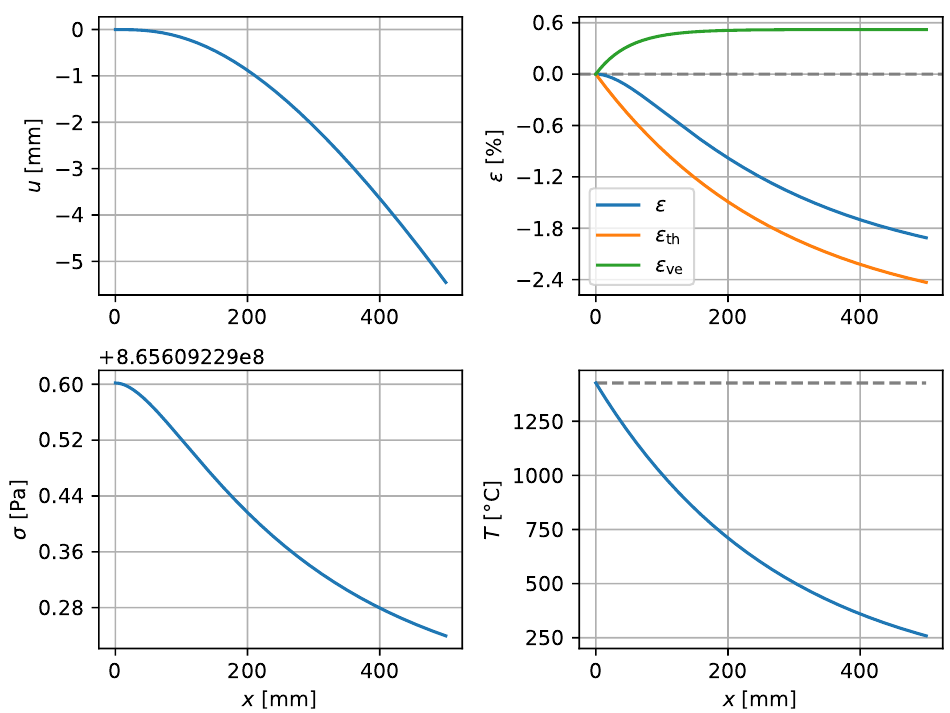
Figure 7. Artificial high-viscosity example, t ret = 1s, up to x = 500mm. v =